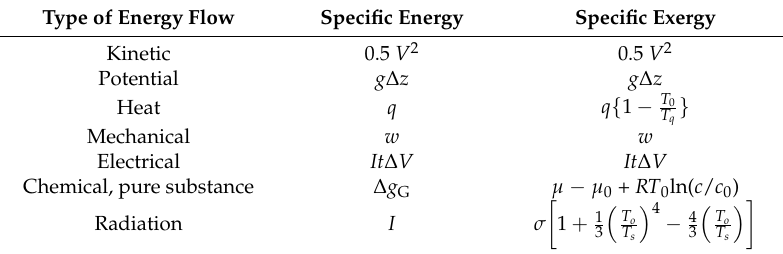
Table 1. Specific exergy expressions for different flows.